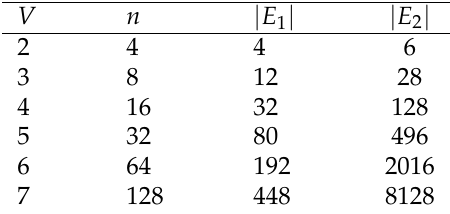
Table 3. The relationship between V , n ,